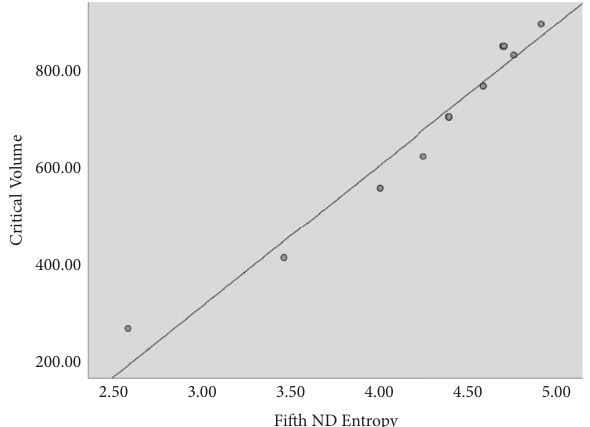
Figure 7: Graphical representation of LRM between critical vol- ume and the fifth ND entropy.